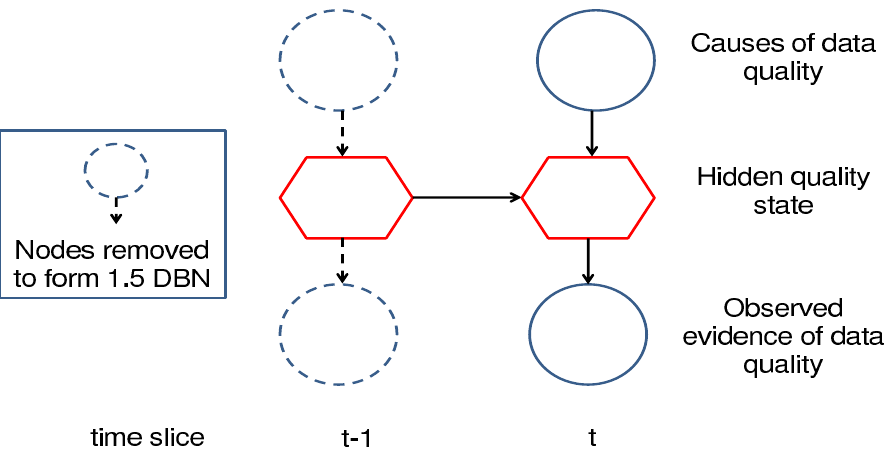
Figure 2. The two time-slice structure of the Dynamic Bayesian Network used to perform quality state inference for each incoming sample. The interface algorithm only requires the node variables from the previous slice that are connected to the current slice to be involved in the quality state inference. This is known as the 1.5 DBN